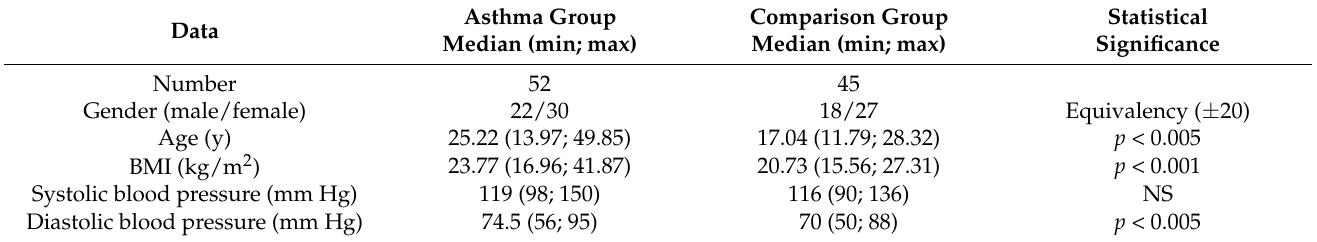
Table 1. Demographic